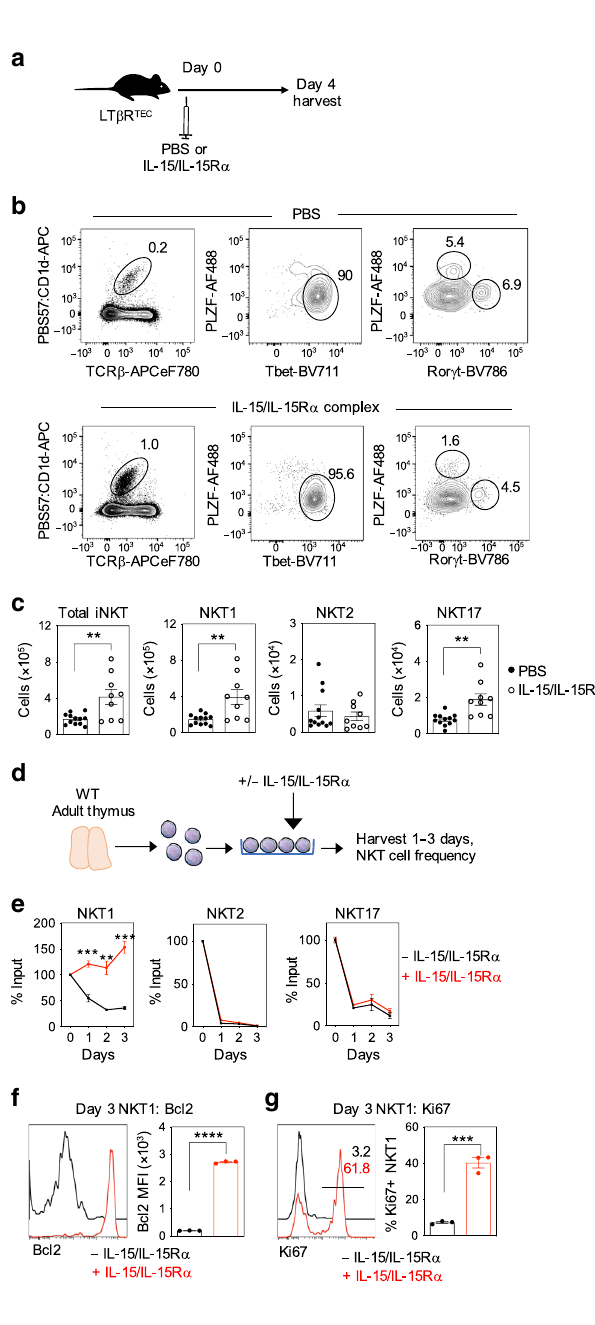
Fig. 5 IL-25 production from thymic tuft cells controls intrathymic iNKT2 cells. Flow cytometric detection ( a ) and quantitation ( b ) of TCR β + PBS57:CD1d tetramer + iNKT cells and NKT1, 2 and 17 subsets in WT ( n = 8 biologically independent samples, closed symbols) and tuft cell-de fi cient Pou2f3 − / − ( n = 7 biologically independent samples, open symbols), over three indepdendent experiments. Signi fi cant P values using two-tailed unpaired t test as follows: no. of NKT2 P = 0.0033 and % NKT2 P = 0.0253. Flow cytometric detection and quantitation ( c ) of total iNKT and iNKT subsets in BALB/c WT ( n = 9 biologically independent samples, closed symbols) and Il25 − / − ( n = 7 biologically independent samples, open symbols) mice, over four independent